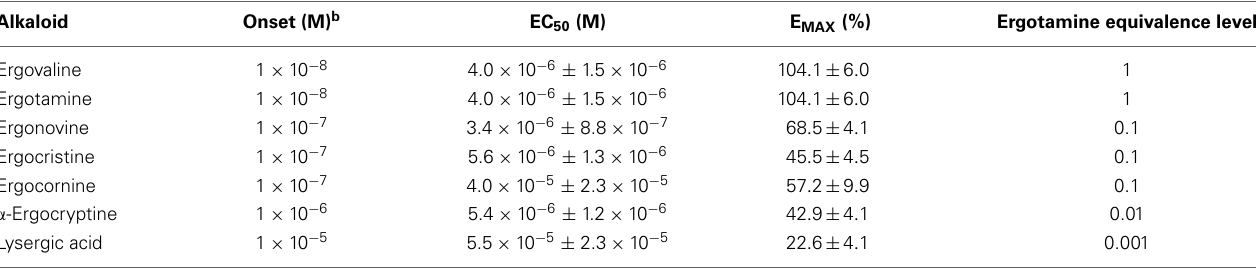
a Taken from Klotz et al. (2006, 2007, 2010).